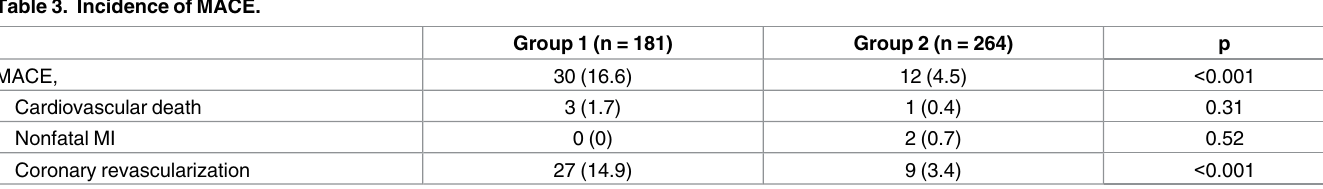
Table 3. Incidence of MACE.